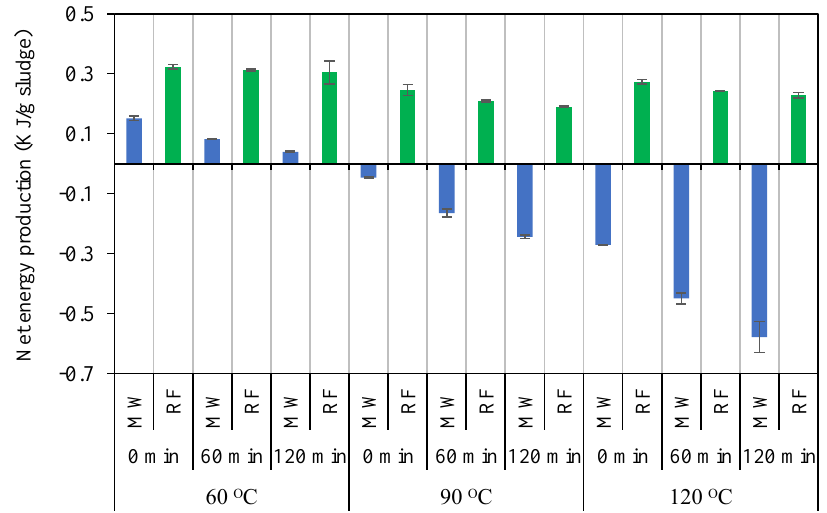
Figure 5 . The net energy production of the MW- and RF-pretreated digesters. Figure 5. The net energy production of the MW- and RF-pretreated digesters.